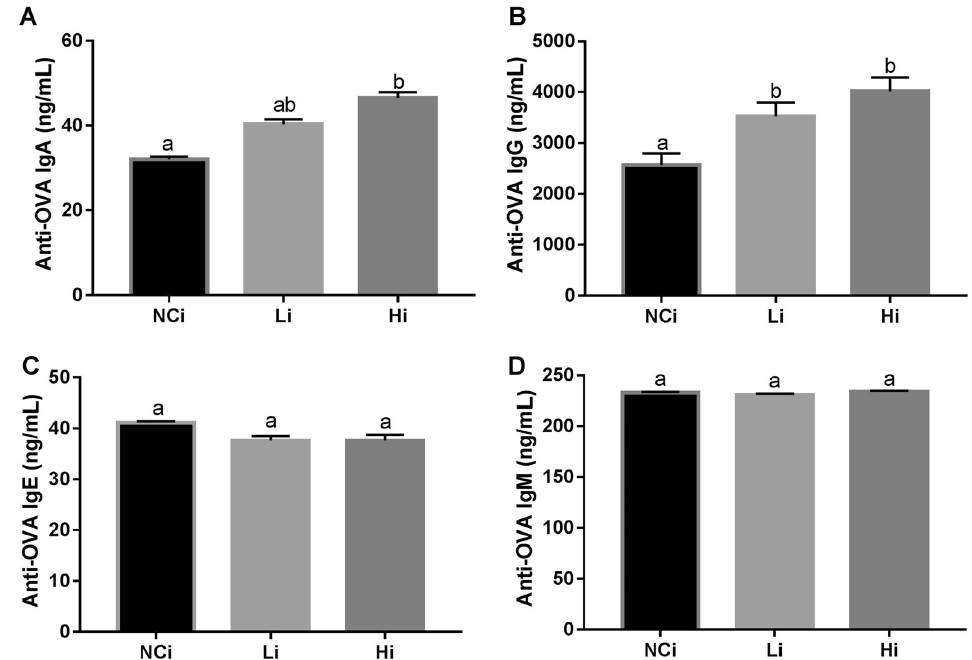
Figure 2. Concentrations of OVA-specific immunoglobulins in the serum of OVA-injected (s.c.) mice. Levels of the OVA-specific immunoglobulins ( A ) IgA, ( B ) IgG, ( C ) IgE, and ( D ) IgM in the serum. NCi mice gavaged with saline, negative control, Li mice gavaged with low-dose LcSFB, Hi mice gavaged with high-dose LcSFB. Different superscript letters (a, b) indicate significant differences at p < 0.05; one-way ANOVA with Tukey HSD post-hoc tests ( n =